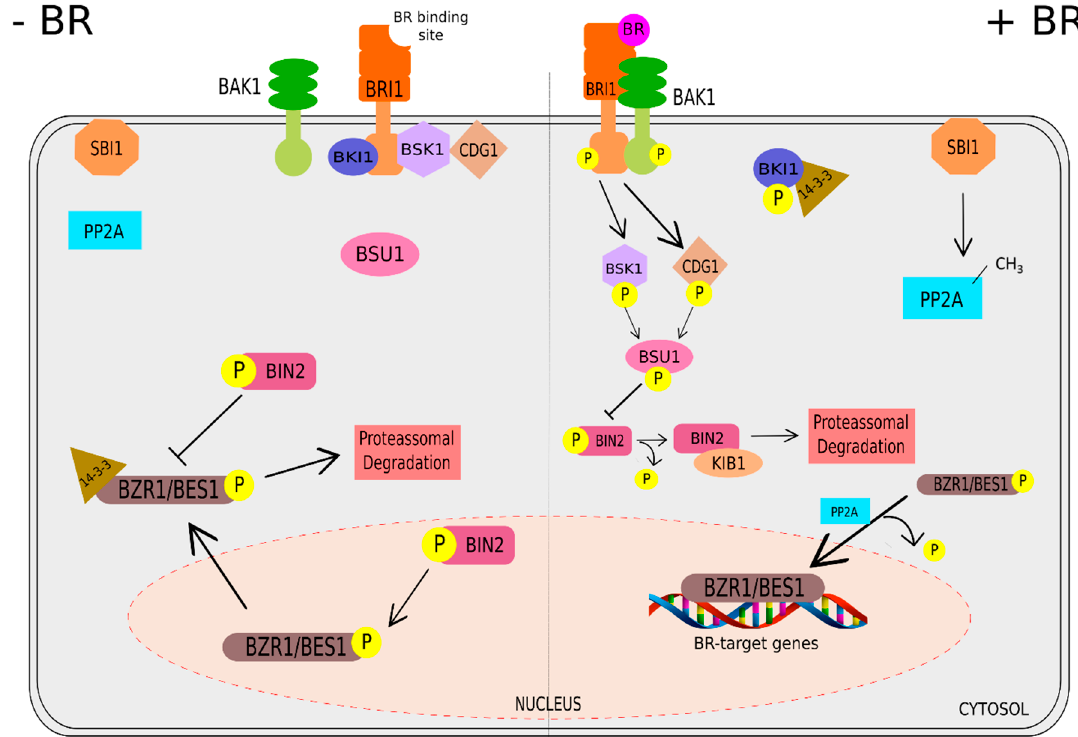
Figure 2. Current model of the signaling pathway in the presence or absence of brassinosteroids (BRs) in Arabidopsis . In the absence of BR, the receptor kinase BRI1 (BRASSINOSTEROID INSENSITIVE 1) does not heterodimerize with its coreceptor BAK1 (BRI1-ASSOCIATED RECEPTOR KINASE 1), maintaining their inactive forms. Consequently, BIN2 (BRASSINOSTEROID-INSENSITIVE 2), a negative regulator of BR signaling pathway, is free to constitutively phosphorylate BZR1 (BRASSINAZOLE RESISTANT 1) and BES1 (BRI1-EMS SUPPRESSOR 1), the two master transcription factors of BR-induced responses, inducing their interactions with 14-3-3 proteins that, in turn, promotes the cytoplasmic retention of BZR1/BES1, suppressing their DNA-binding activity. On the other hand, in the presence of BR, the activation of BRI1 triggers its autophosphorylation and partial kinase activity and dissociation from its inhibitor BKI1, which is attached at the BRI1 kinase domain. This leads to its heterodimerization with BAK1, and transphosphorylation to complete BRI1 kinase activity. Activated BRI1 then phosphorylates BSKs (BR-SIGNALING KINASES) and CDG1 (CONSTITUTIVE DIFFERENTIAL GROWTH 1) which both phosphorylate BSU1 (BRI1 SUPPRESSOR 1), leading to BIN2 dephosphorylation. BIN2 is subsequently restrained by KIB1 (KINK SUPPRESSED IN BZR1-1D), which prevents the association of BIN2 with BZR1/BES1 and facilitates its ubiquitination and degradation. The inactivated form of BIN2 allows BZR1 and BES1 to enter into the nucleus and regulate the expression of BR target genes. Additionally, PP2A (PHOSPHATASE 2A) also positive regulates BR signaling by dephosphorylating BZR1 and BES1, whereas SBI1 (SUPPRESSOR OF BRI1) deactivates BRI1 through the methylation of PP2A.